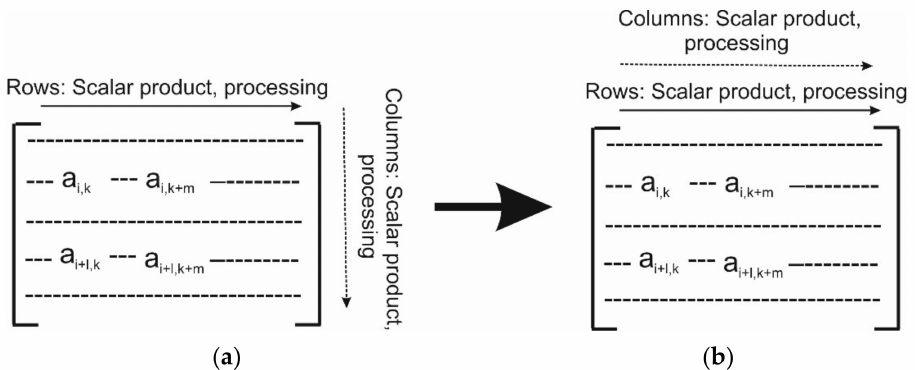
Figure 3. Obtaining a row-oriented scheme for performing a basic transformation: ( a ) traditional algorithm based on the Householder reflection; ( b ) row-oriented transformation scheme.